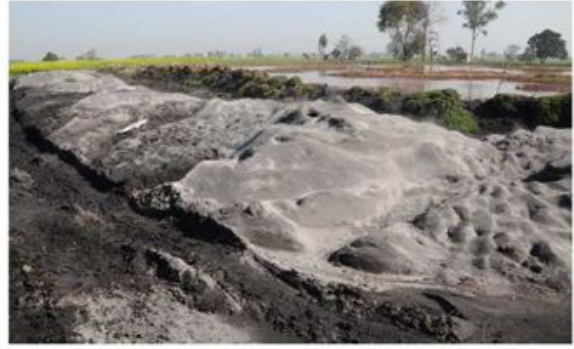
Figure 1: Rice husk producing soil